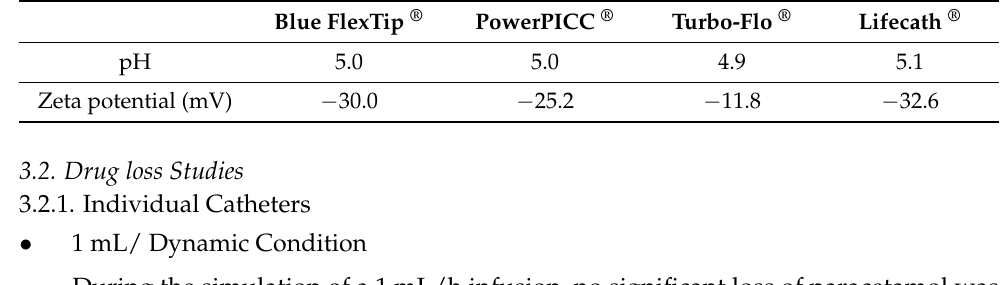
Table 3. Zeta potential of polyurethane (Blue FlexTip ® , PowerPicc ® , and Turbo-Flo ® ) and silicone catheters (Lifecath ®